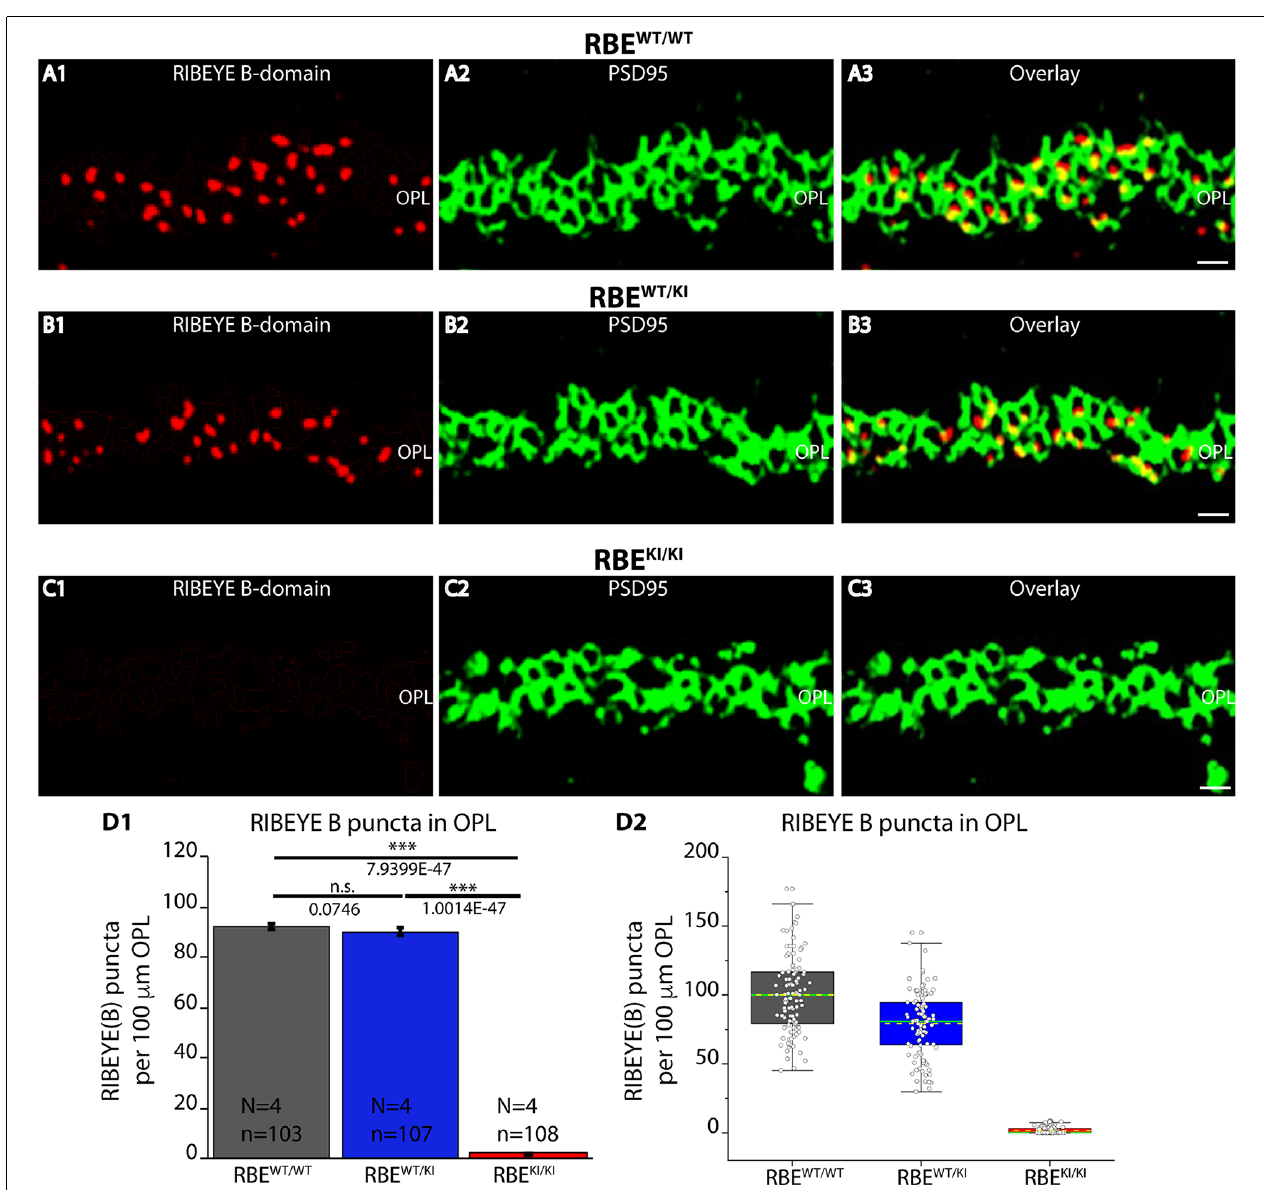
FIGURE 3 | Quantification of RIBEYE B-domain puncta in the OPL of RBE WT/WT , RBE WT/KI , and RBE KI/KI mice. (A1–A3,B1–B3,C1–C3) 0.5 µ m-thin retina sections of RBE WT/WT , RBE WT/KI , and RBE KI/KI mice were double-immunolabeled with mouse monoclonal antibody (2D9) against RIBEYE B-domain domain and rabbit polyclonal antibody against PSD95. The OPL was analyzed at high magnification to determine RIBEYE B-domain puncta number/density in the OPL. (D1,D2) Quantification of RIBEYE B-domain puncta in OPL in (D1,D2) demonstrates that the number of RIBEYE B-domain puncta is unchanged between RBE WT/WT and RBE WT/KI . RIBEYE B-domain puncta were completely absent in the OPL of RBE KI/KI mice. The bar graphs in (D1) show means ± S.E.M. (n.s., p > 0.05; ∗∗∗ p ≤ 0.001). In the box and whisker plots (D2) of the data from (D1) , means values are shown as horizontal yellow dotted line and median values by horizontal green solid line. The boxes represent the 25th-75th percentiles and whiskers represent 1.5 times IQR. The statistical analyses were performed by Mann-Whitney U -tests and Kolmogorov-Smirnov tests. Abbreviations: OPL, outer plexiform layer; RBE, RIBEYE; S.E.M., standard error of the mean; n.s. non-significant; IQR, interquartile range; N = number of mice; n = number of analyzed confocal images. Scale bar: 5 µ m.